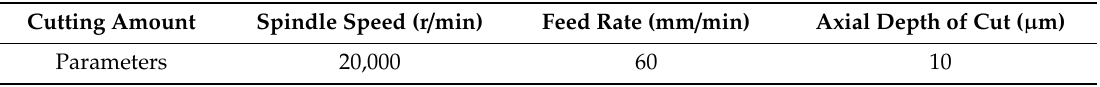
Table 2. Cutting parameters of fabricating micro-textures.